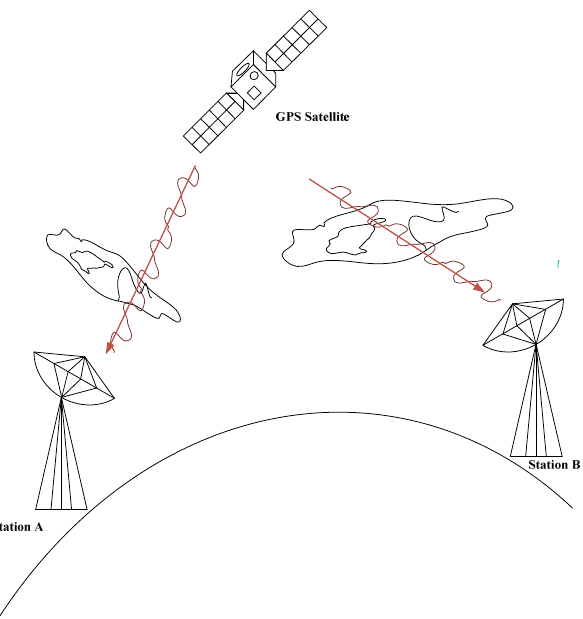
Figure 4. Station clock information by GPS common view technique.